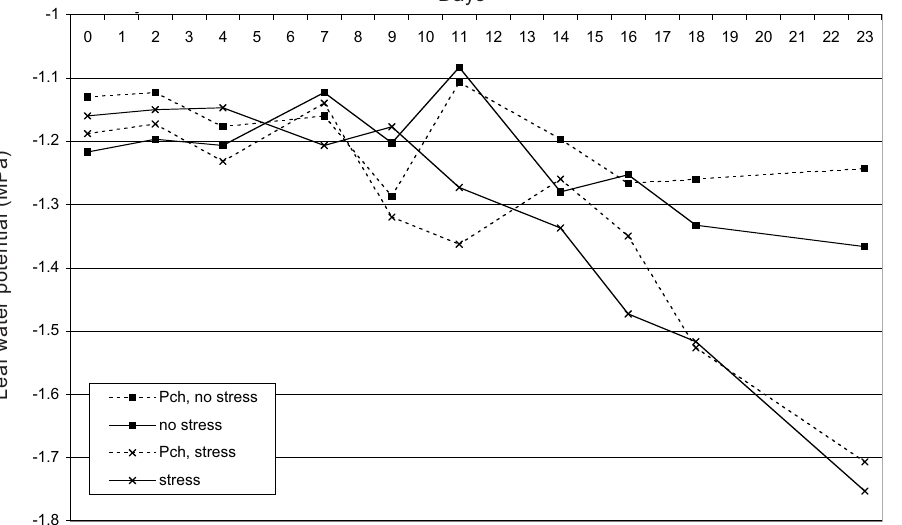
Fig. 2. Effects of water stress on leaf water potential of infected and uninfected Zinfandel, Year 1,